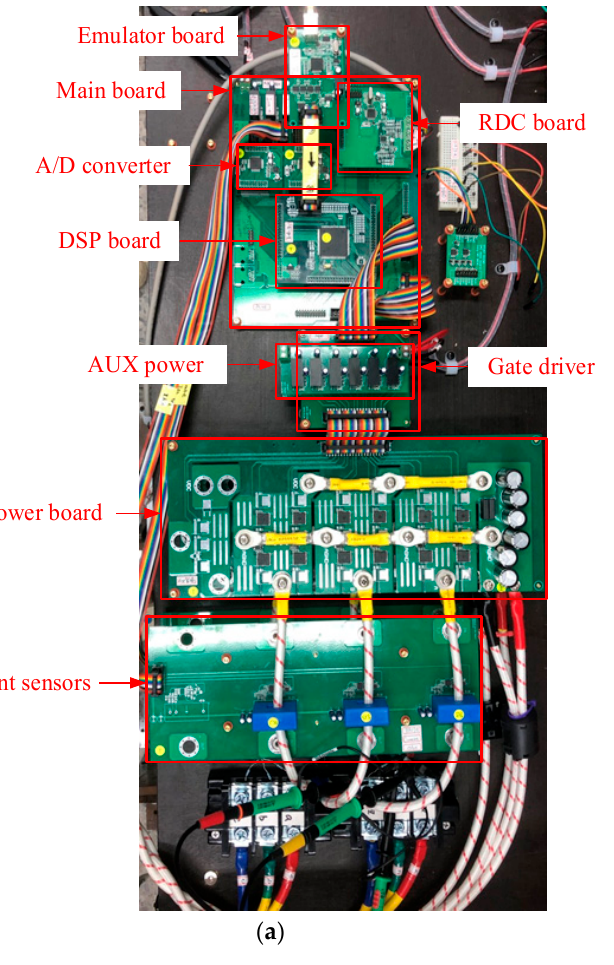
Figure 4. Laboratory prototype photos: ( a ) motor driver; ( b ) test bed.